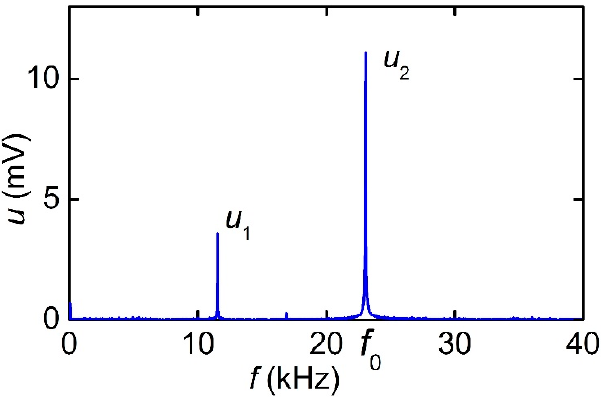
Figure 9. The frequency spectrum of the ME voltage generated by the MFC-PZT structure with a period T 1 of 250 μ m when magnetized along the wires by the H -field of approximately 40